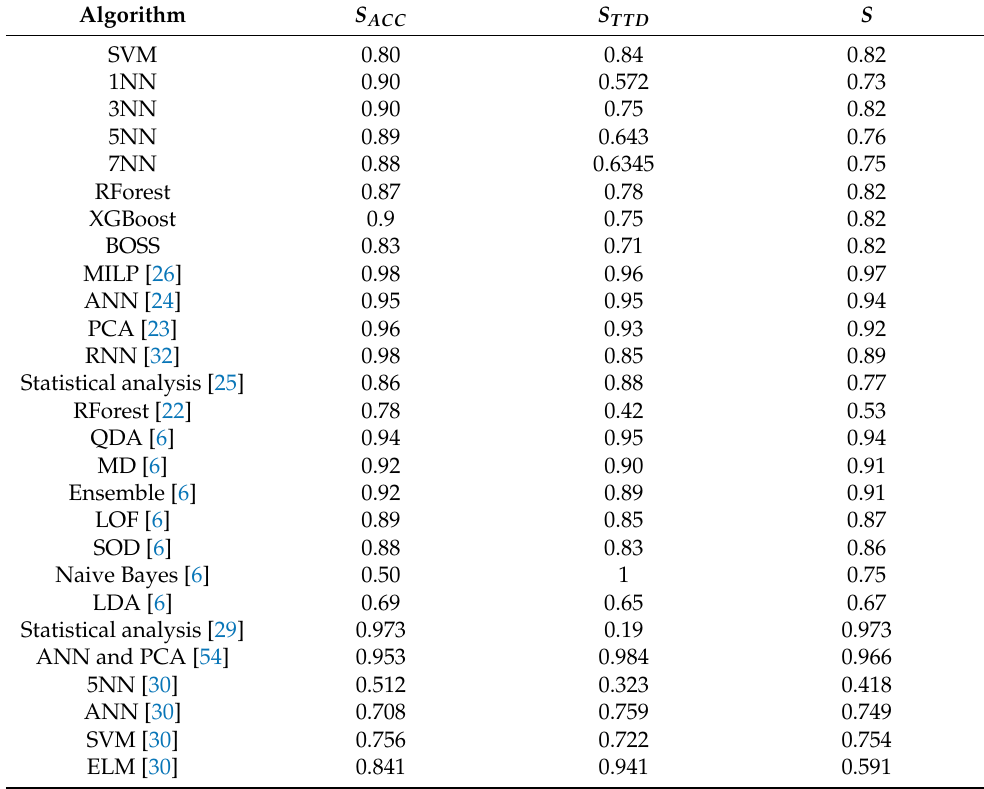
Table 4. S ACC , TTD , and S in the stage 1 using 6 h granularity.